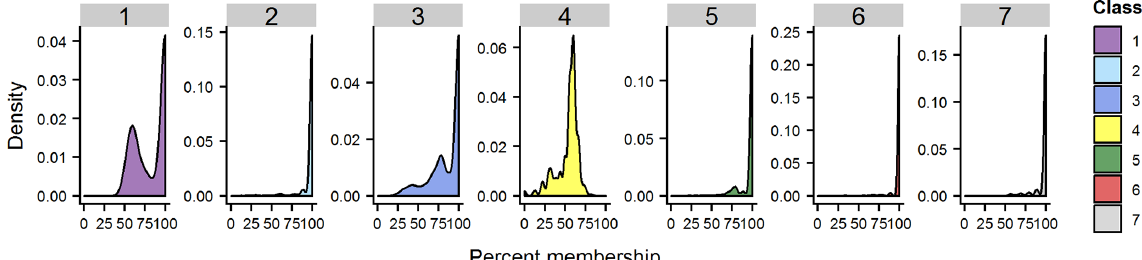
Figure 9. Density distributions of percent agreement of watersheds with the classification in Fig. 5 by watershed class. Classes: Southern Manitoba (1), Pothole Till (2), Pothole Glaciolacustrine (3), Major River Valleys (4), Interior Grasslands (5), High Elevation Grasslands (6), Sloped Incised (7).